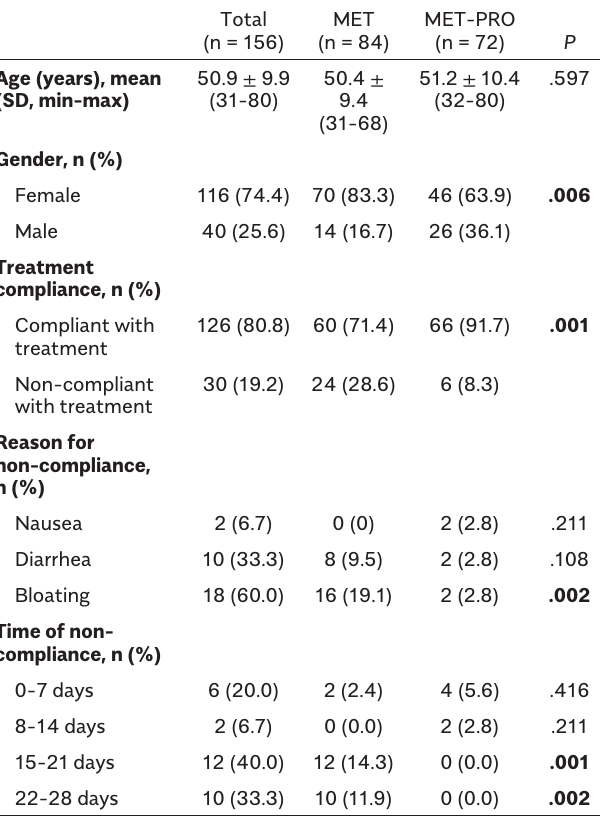
Table 1. Patient Demographics and Compliance with Treatment Total (n =